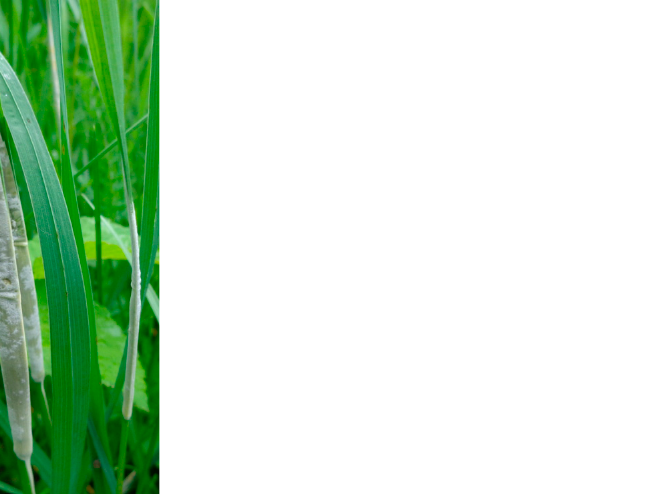
Figure 6. Number of Bromus erectus tillers (per m 2 ) infested with Epichloë bromicola in tiny, small, and large fragments (black bars) and in the corresponding control plots (open bars) in the first year ( a ), second year ( b ), and third year ( c ) of the experiment. Means ± SE are shown. Redrawn from Groppe et al. [30]. 3.9.3. Altered Mutualistic and Competitive Interactions in Fragments Habitat fragmentation can affect mutualistic interactions if the abundance of one or the other of the partners involved or even of alternative partners is affected [74]. Changes